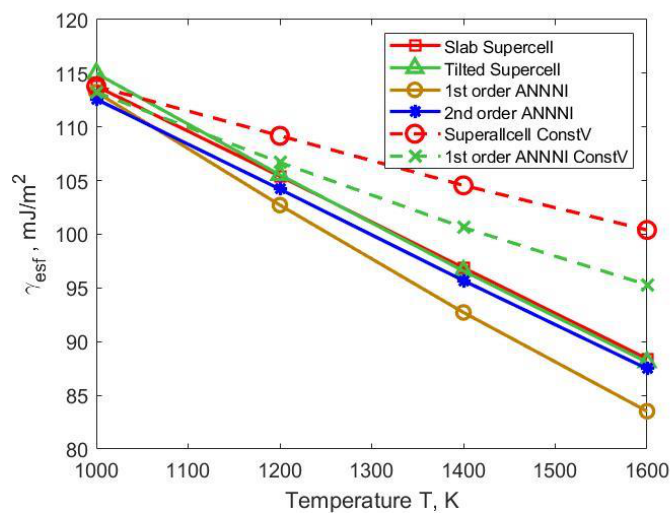
Figure 12. Temperature-dependent extrinsic stacking fault energy along [112] direction of FCC paramagnetic nickel. paramagnetic